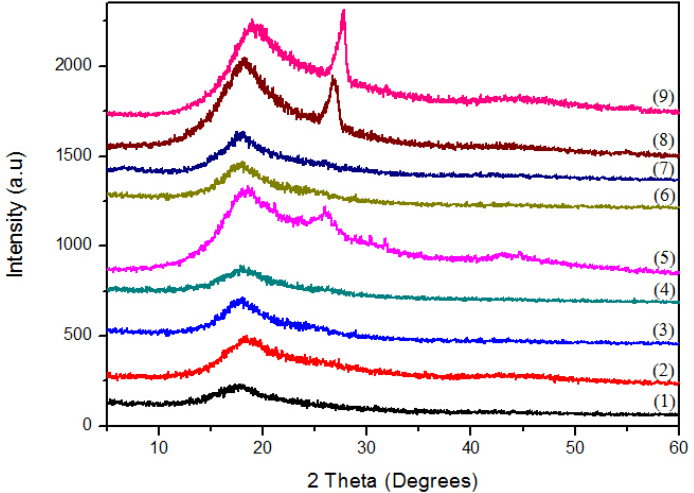
Figure 2. X-ray diffraction (XRD) patterns of PSU-CNT and PSU-GNP samples. Numbers (1)–(9) in parentheses correspond to numbers of samples for which compositions are described in Table 1.